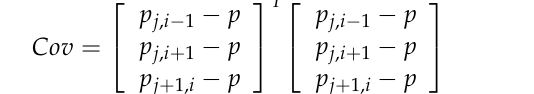
Figure 4. 3D zigzag-line welding seams point cloud data neighborhood normal vectors; ( a ) Point cloud data; ( b ) Method for establishing neighborhood normal vectors; ( c ) Neighborhood normal vectors.